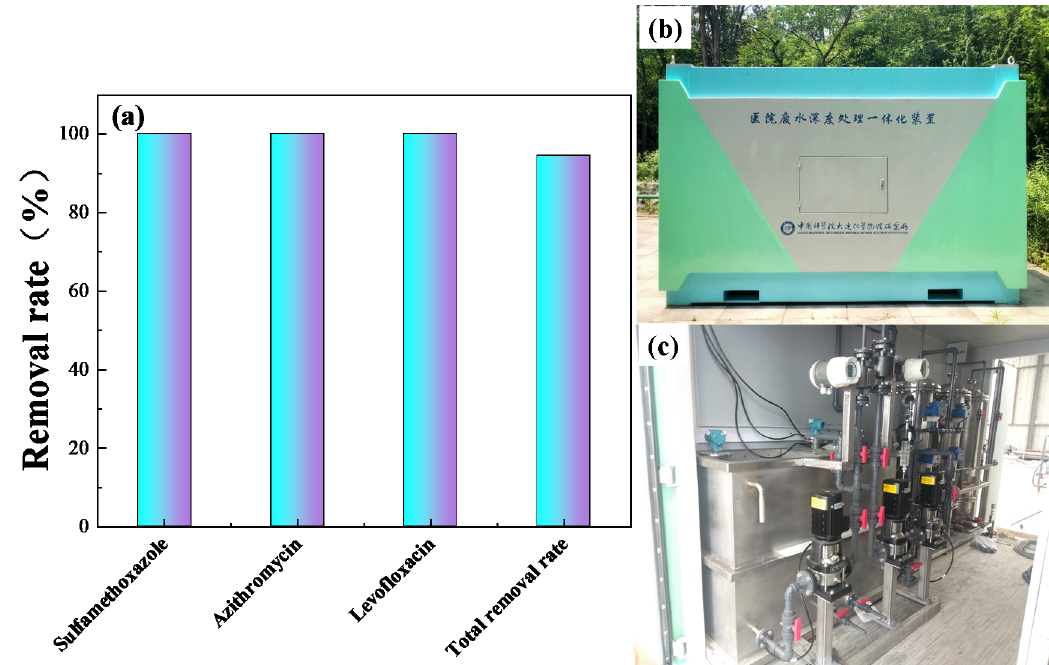
Figure 9. ( a ) Treatment of wastewater from novel coronavirus epidemic. ( b ) and ( c ) Integrated device for advanced treatment of hospital wastewater.